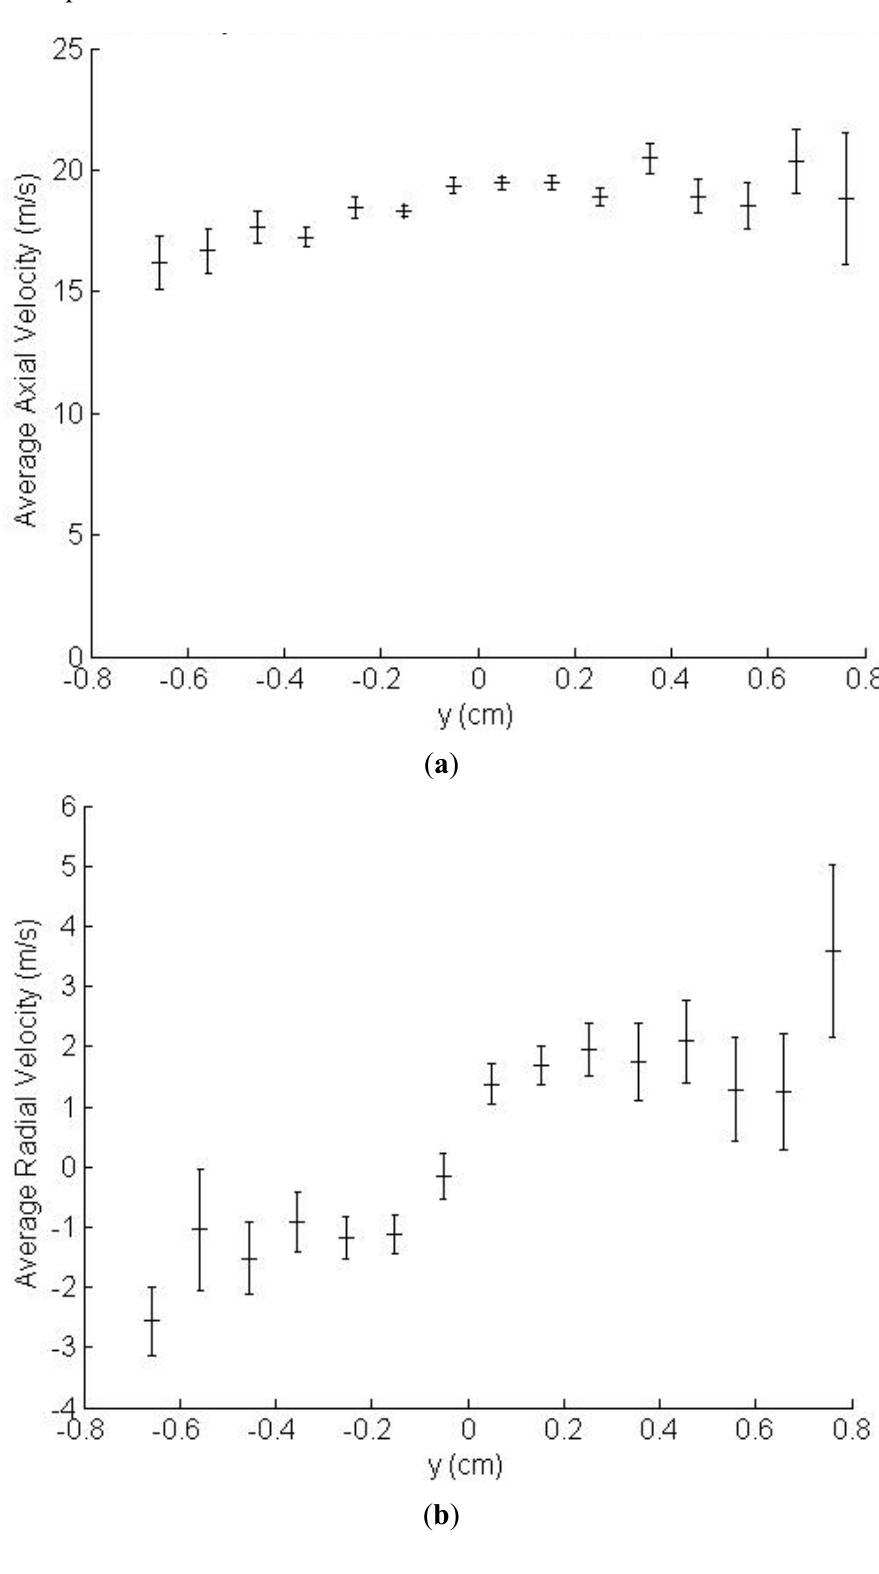
Figure 12. Experiment 3: ( a ) Particle axial velocities and ( b ) particle radial velocities at 10 cm from cap